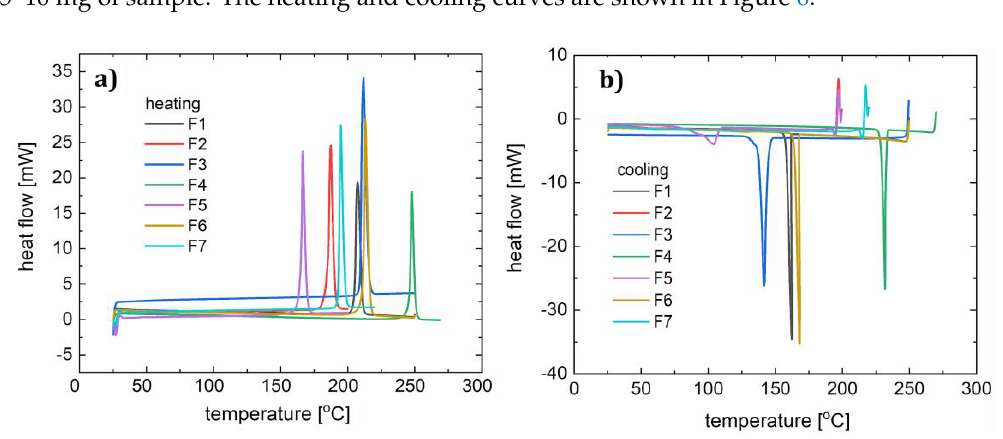
Figure 6. DSC curves for samples F1–F7: heating ( a ) and cooling ( b ).